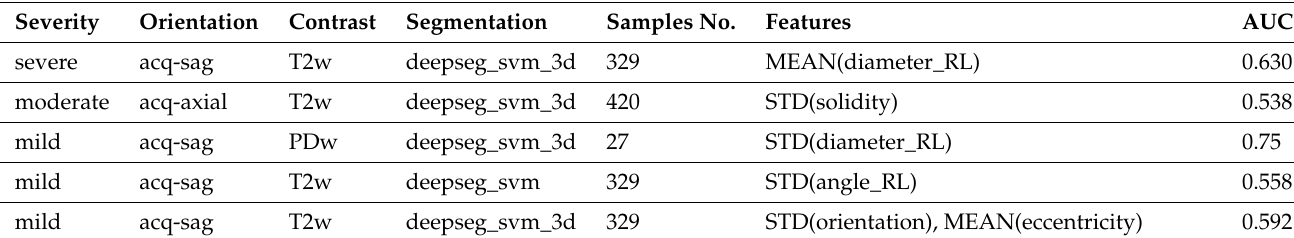
Table 7. The attributes of logistic models fit on metric data which was standardized to a common scale and harmonized by scanner used via CovBat. Severity indicates the class attempting to be distinguished from all others (binary classification), while orientation, contrast, and segmentation represent the acquisition methodology associated with the model. Features contains the list of features used to train the model, as selected by SciKit-Learn’s SelectFdr